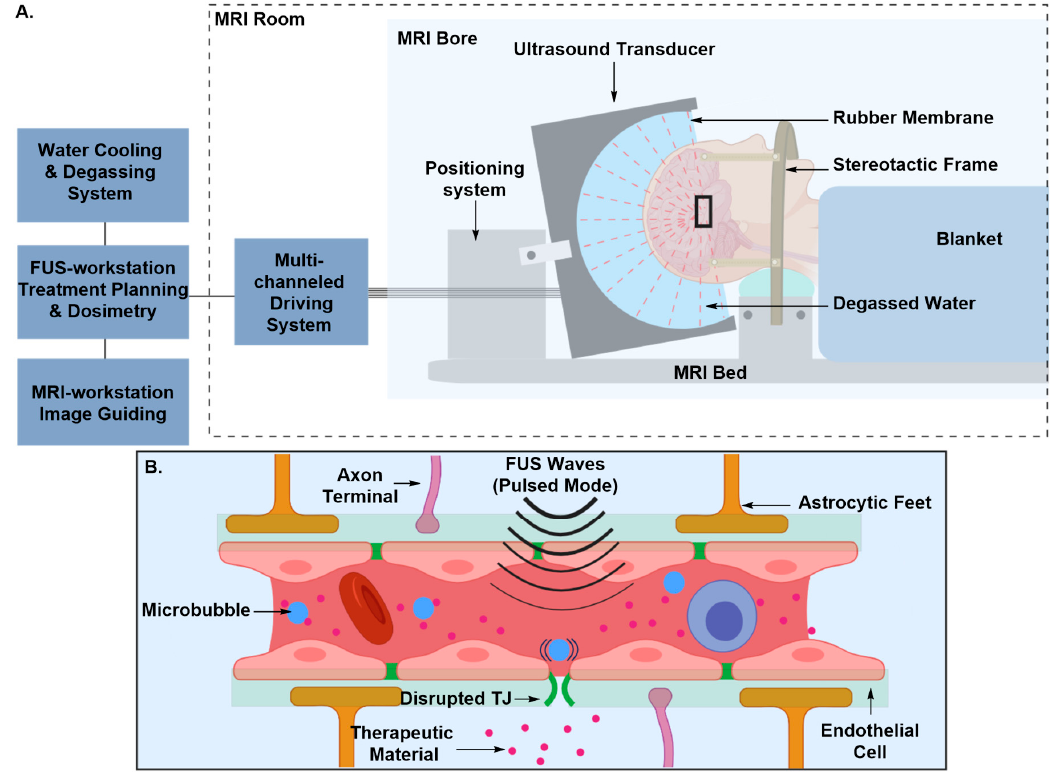
Figure 9. Principle of BBB disruption using MRI-guided microbubble-assisted focused-ultrasound technique (MB-FUS). ( A ) The patient’s head is rested in a semi-spherical ultrasound transducer integrated into an MRI scanner. The transducer is attached to a mechanical positioning system. The focused ultrasound and the magnetic resonance parameters are remotely controlled by electronic interfaces. The patient’s head is immobilized by a stereotactic frame. Overheating of the scalp, skull and brain tissue is minimized by the use of a water interface, which also acts as an acoustic coupler. ( B ) Pretreatment of the patient with microbubbles harnesses the acoustic power and concentrates it to the blood vessel, which attenuates acoustic power levels. Microbubbles move in the direction of the FUS wave propagation and under the influence of the FUS waves they oscillate, micro-streaming the medium surrounding them, inducing mechanical stress that disrupts the TJs between ECs. Figure 9 (A) adapted from Martin et al.